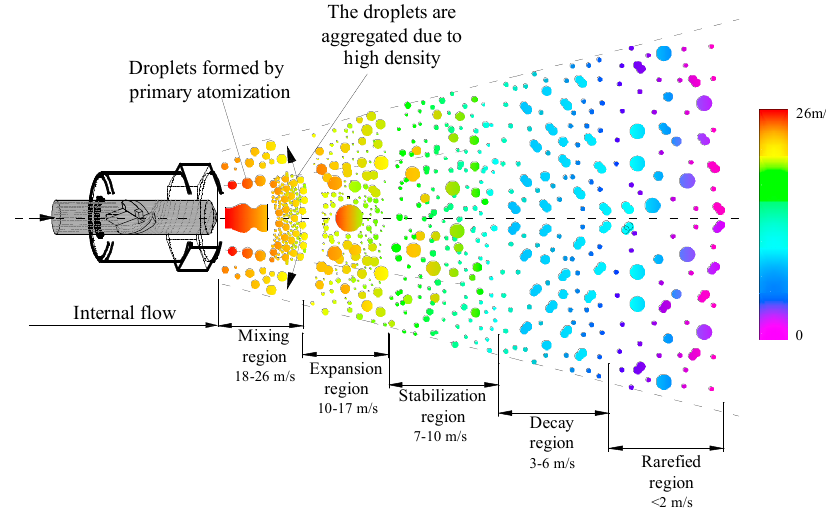
Figure 13. Particle size–velocity spray partition diagram.